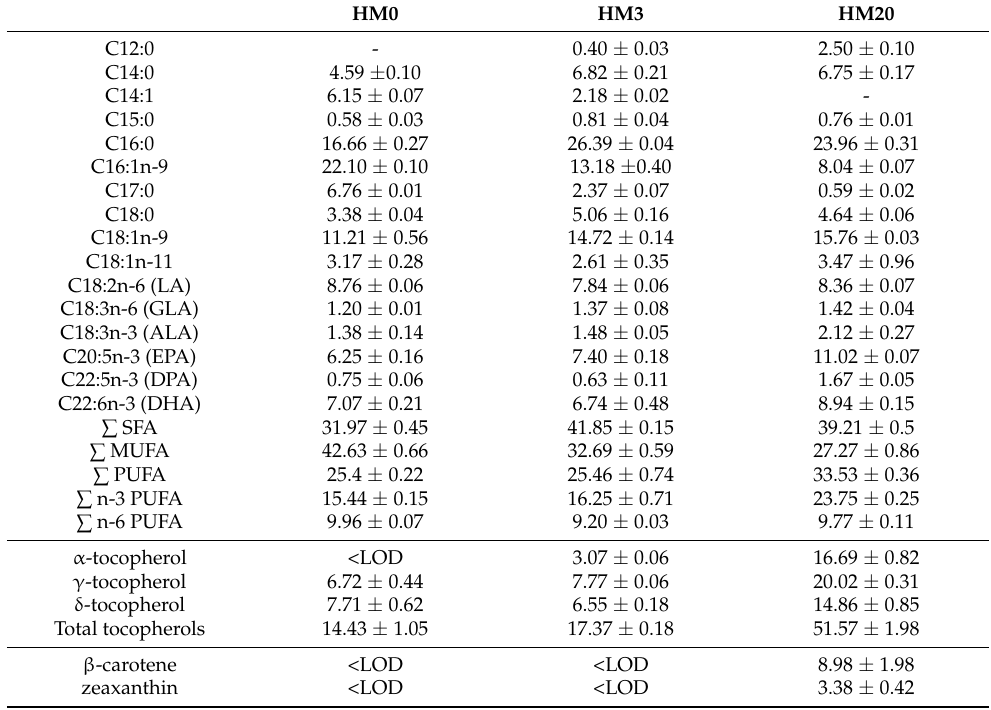
Table 3. FA composition of the experimental diets expressed as percentage of total FA. Toco- pherols and carotenoids are expressed as mg/kg of freeze-dried diet. Results are expressed as mean value ± standard deviation ( n =